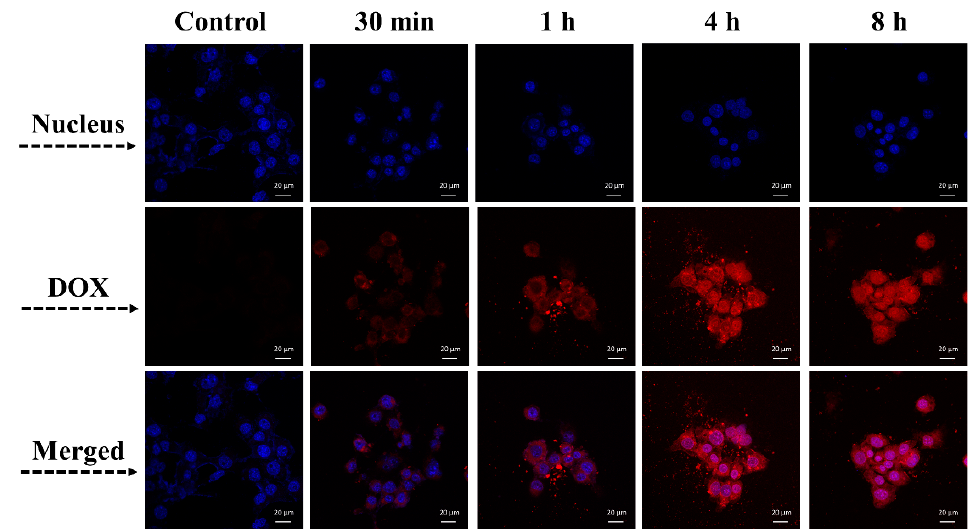
Figure 11. CLSM of DOX@MSCNs-ZnO cultured with 4T1 cells for 30 min, 1 h, 4 h and 8 h. Blue: cell